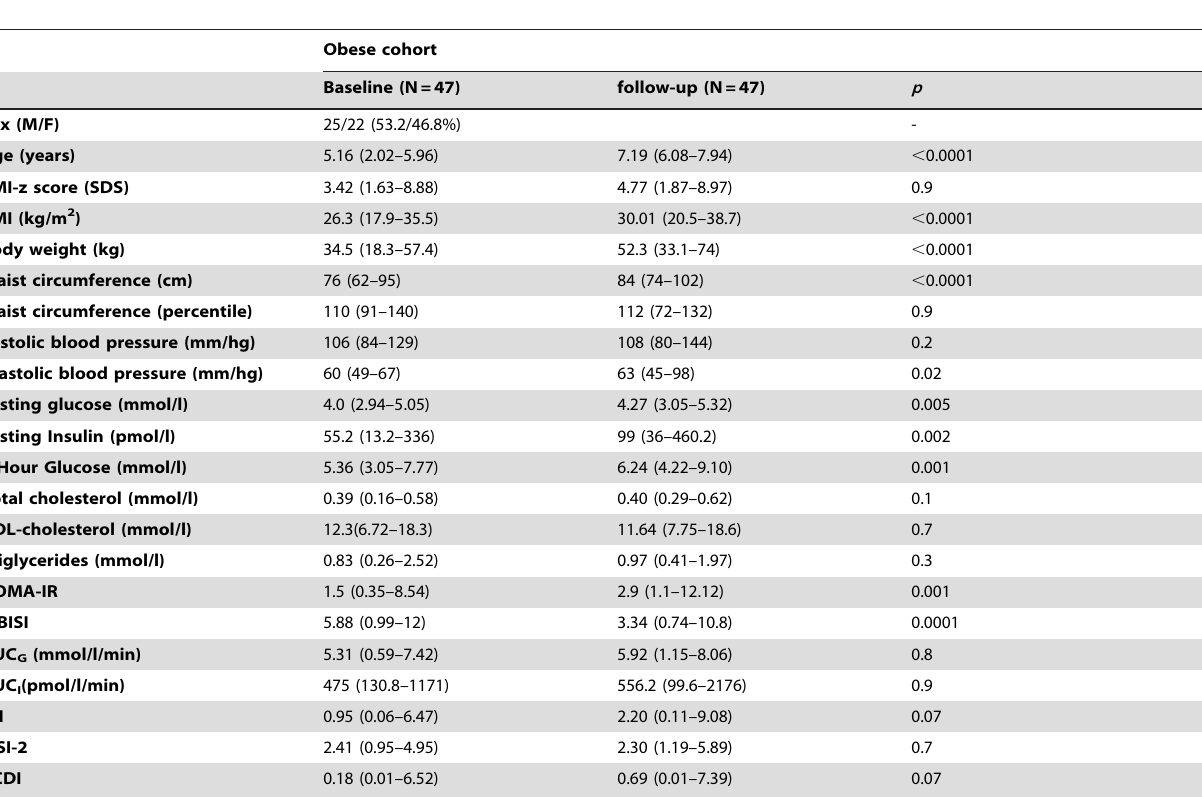
Table 1. Anthropometrics, laboratory and insulin metabolism-related parameters in preschool and school age patients.